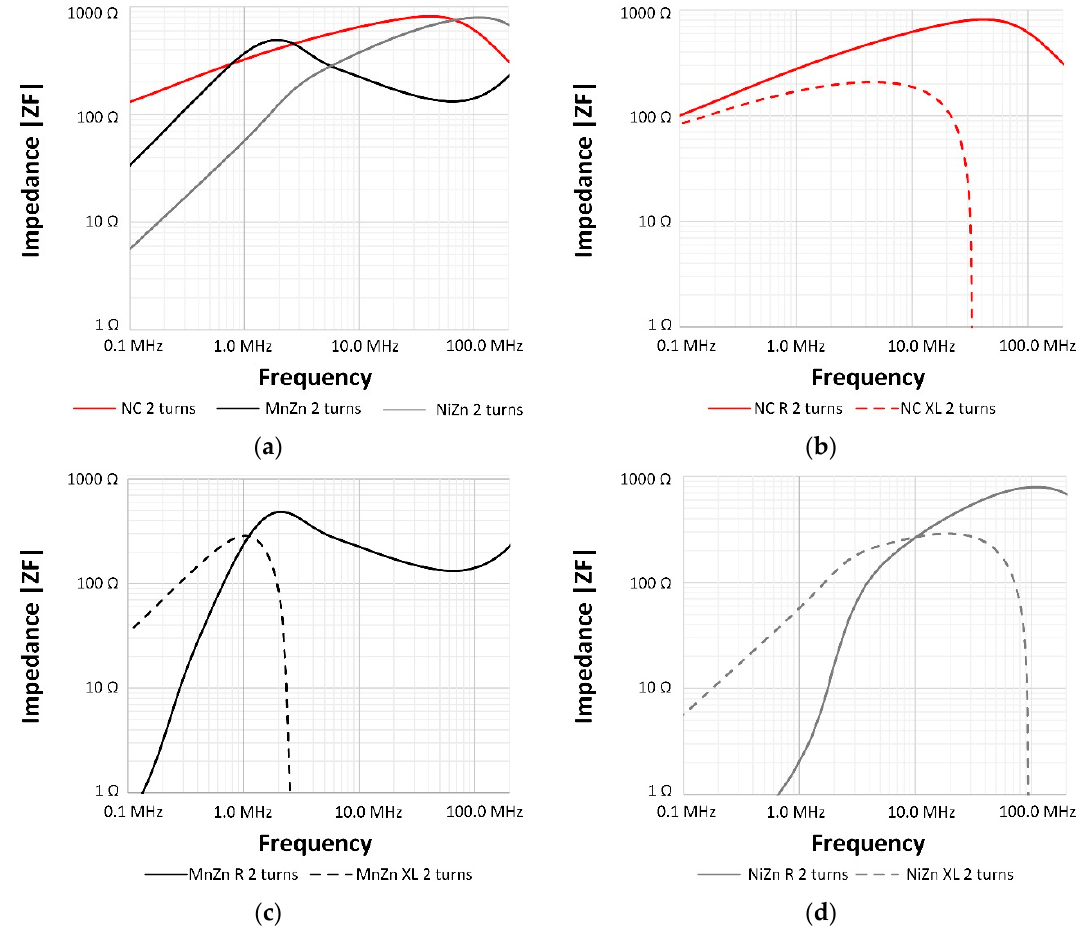
Figure 8. Impedance measurements of the NC, MnZn and NiZn sleeve ferrites after winding around them by two turns: ( a ) Magnitude impedance of three cable ferrites; ( b ) NC R and X L impedance components; ( c ) MnZn R and X L impedance components; ( d ) NiZn R and X L impedance components.